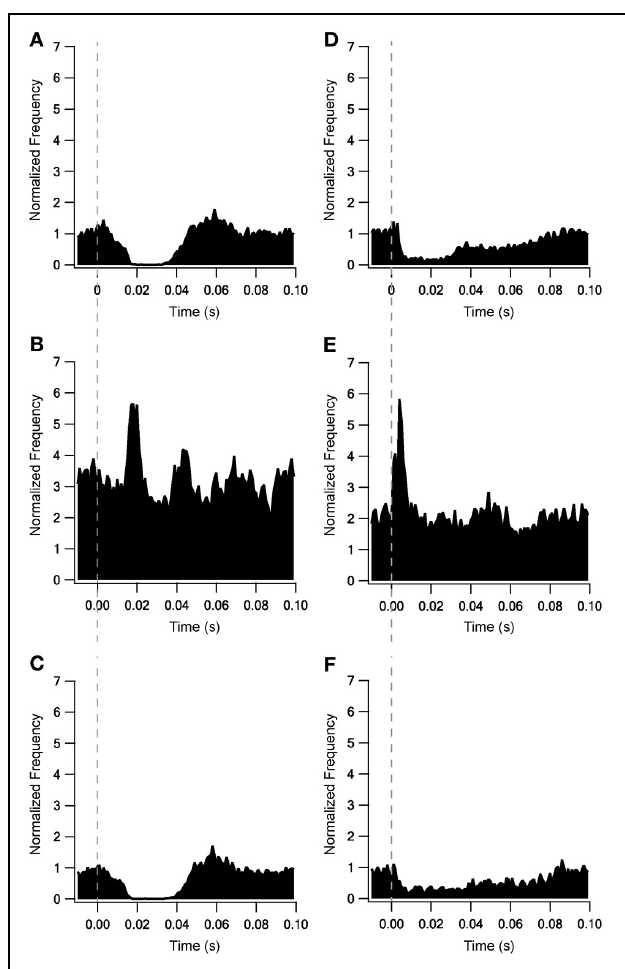
FIGURE 6 | Locking on to the stimulus during 10Hz stimulation of model and experimental results. Model results under control conditions (A) , blockade of inhibition (B) and blockade of excitation (C) . In vitro results from Bugaysen et al. (2011). (D) , Population PSTH of GP neurons in normal extracellular solution ( n = 38). (E) , Population PSTH of GP neurons after applying 50 μ M bicuculline to the extracellular solution ( n = 17). (F) , Population PSTH of GP neurons after applying 15 μ M CNQX and 50 μ M APV to the extracellular solution ( n = 14). The dashed vertical line marks the beginning of the stimulation